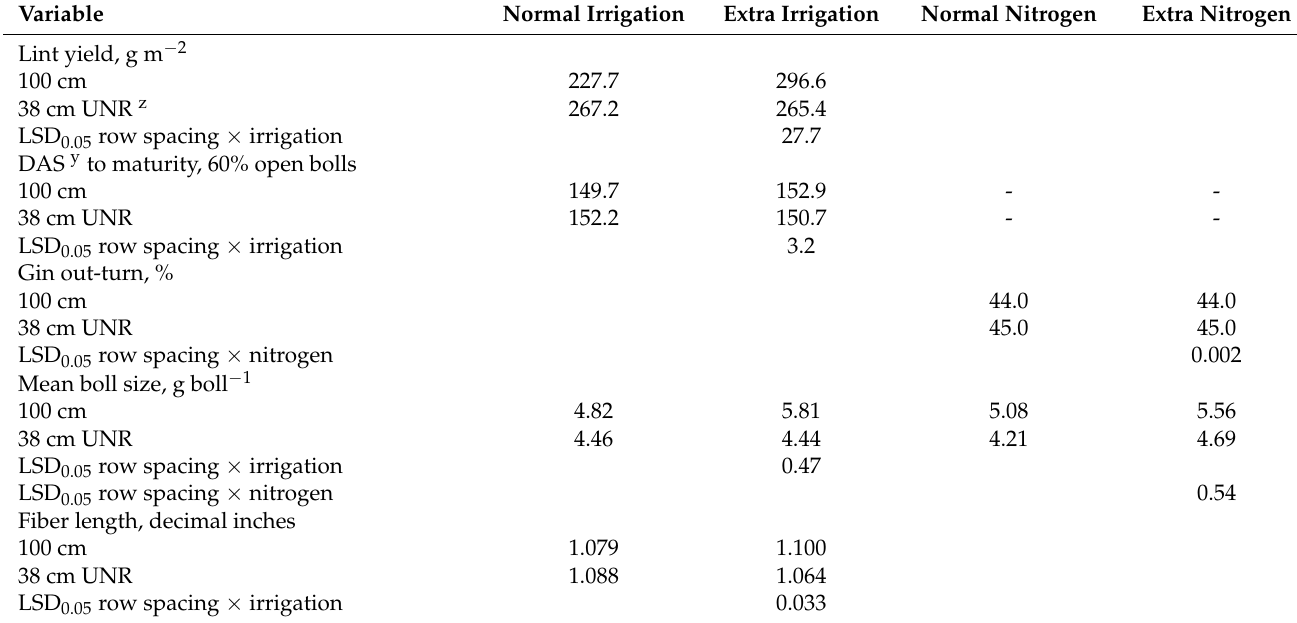
Table 7. Means for significant interactions in Exp. 7. Means for the normal irrigation and normal nitrogen × row spacing treatments for all variables are presented in Tables